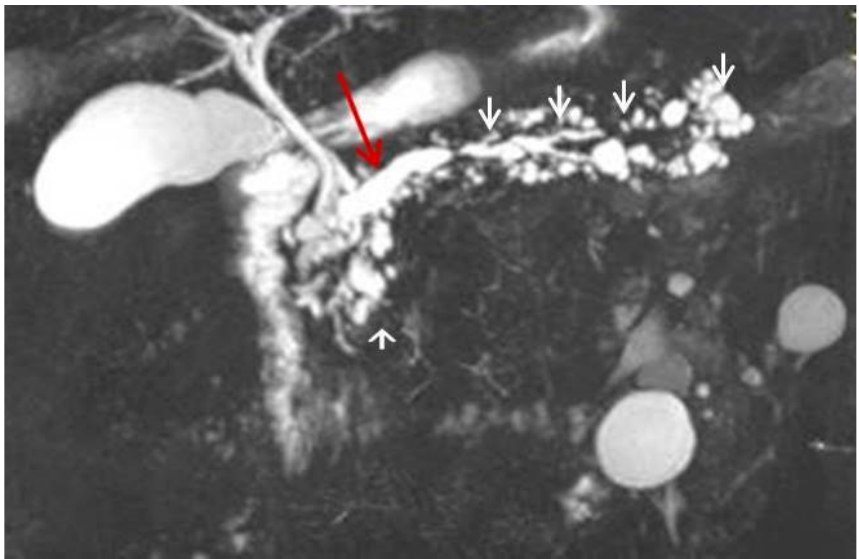
Figure 5. Magnetic resonance cholangiopancreatography (MRCP) exhibits the mixed type of IPMN, with an abnormal dilation of the Wirsung duct (red arrow) and multiple asymmetrically dilated side branches (white arrowheads).